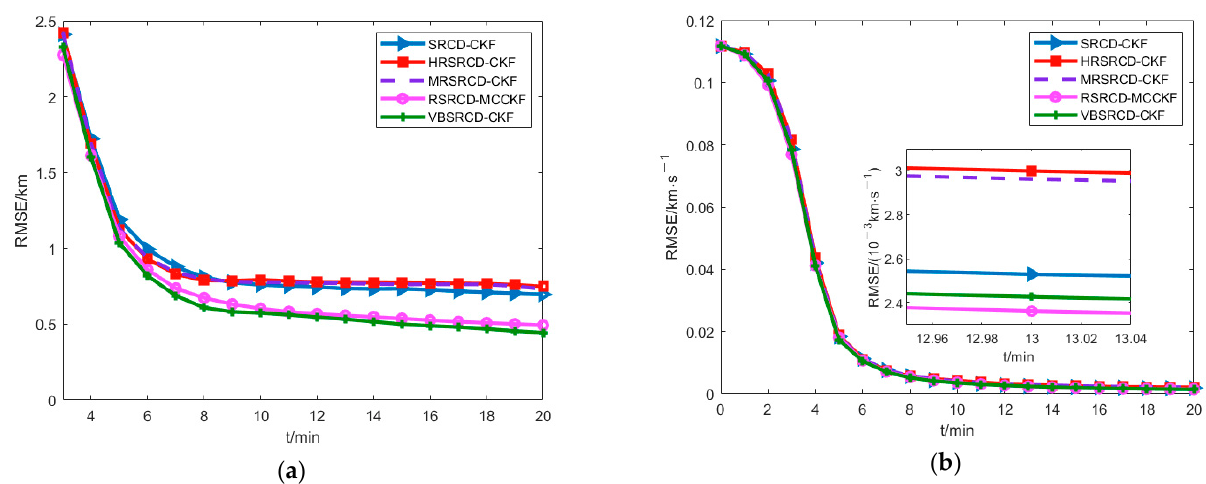
Figure 3. The RMSE comparison of each algorithm under non-Gaussian noise. ( a ) RMSE pos of each algorithm under non-Gaussian noise; ( b ) RMSE vel of each algorithm under non-Gaussian noise.